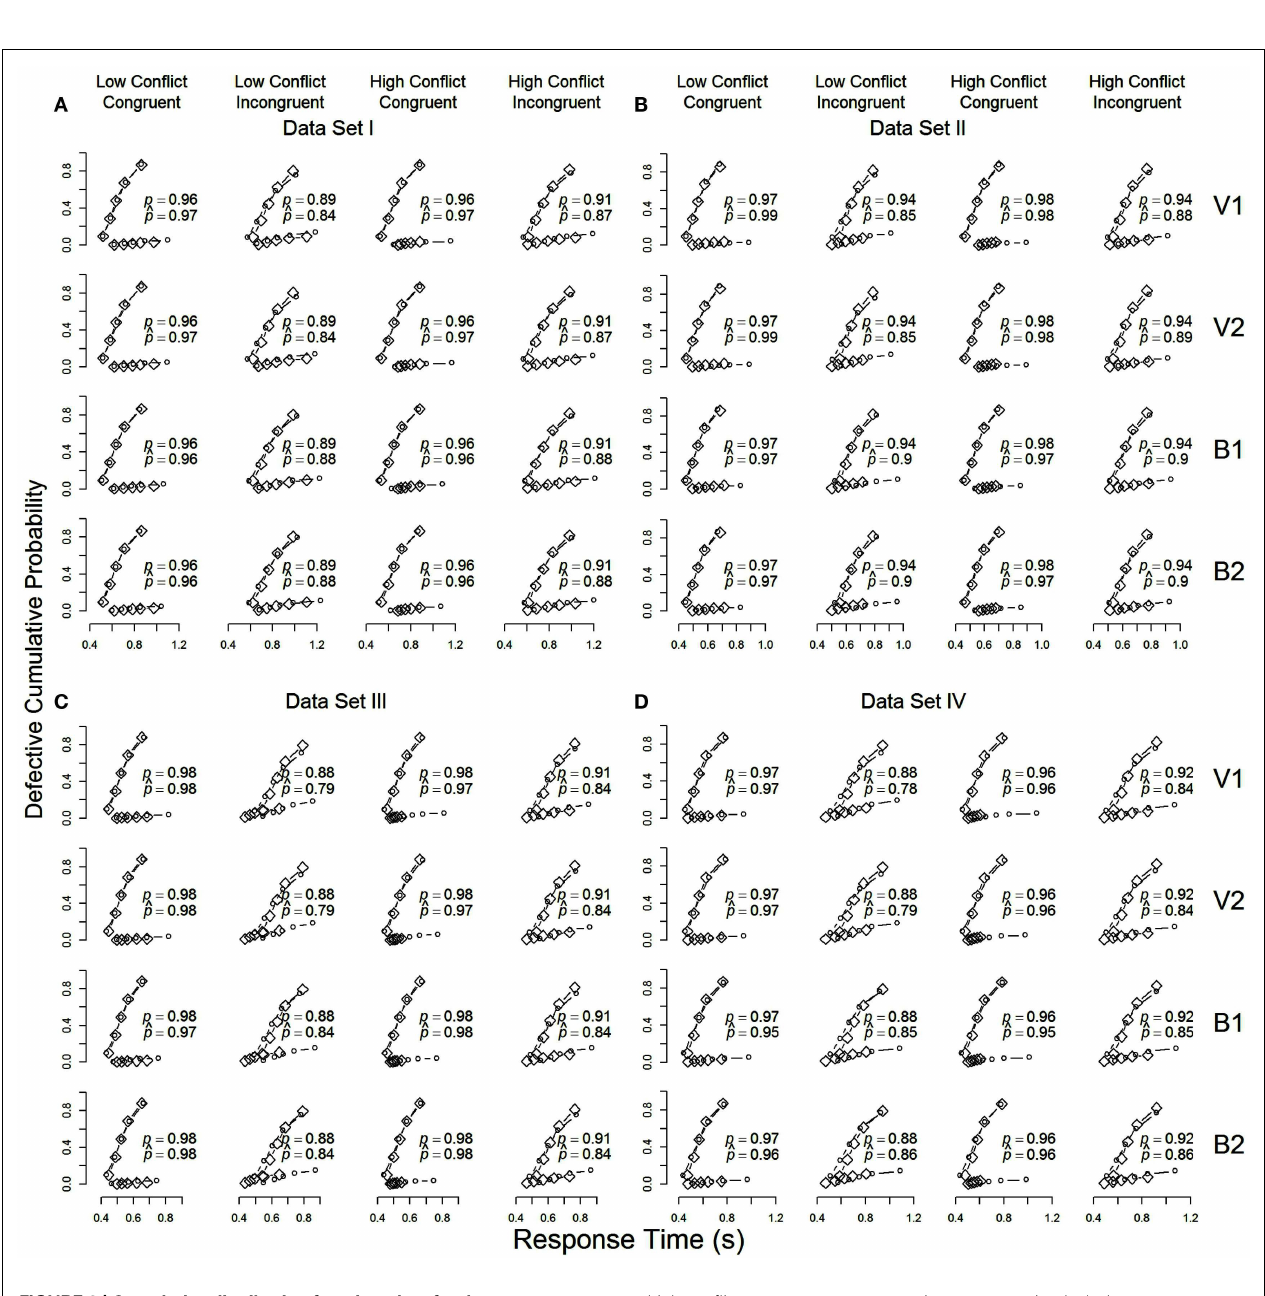
FIGURE 2 | Cumulative distribution function plots for data averaged over participants in each of the four data sets (A–D). Observed data (diamonds) and model predictions (circles) from Models V1 andV2 (“drift” models) and B1 and B2 (“threshold” models) are shown in the rows of each panel. For each condition (low- vs.